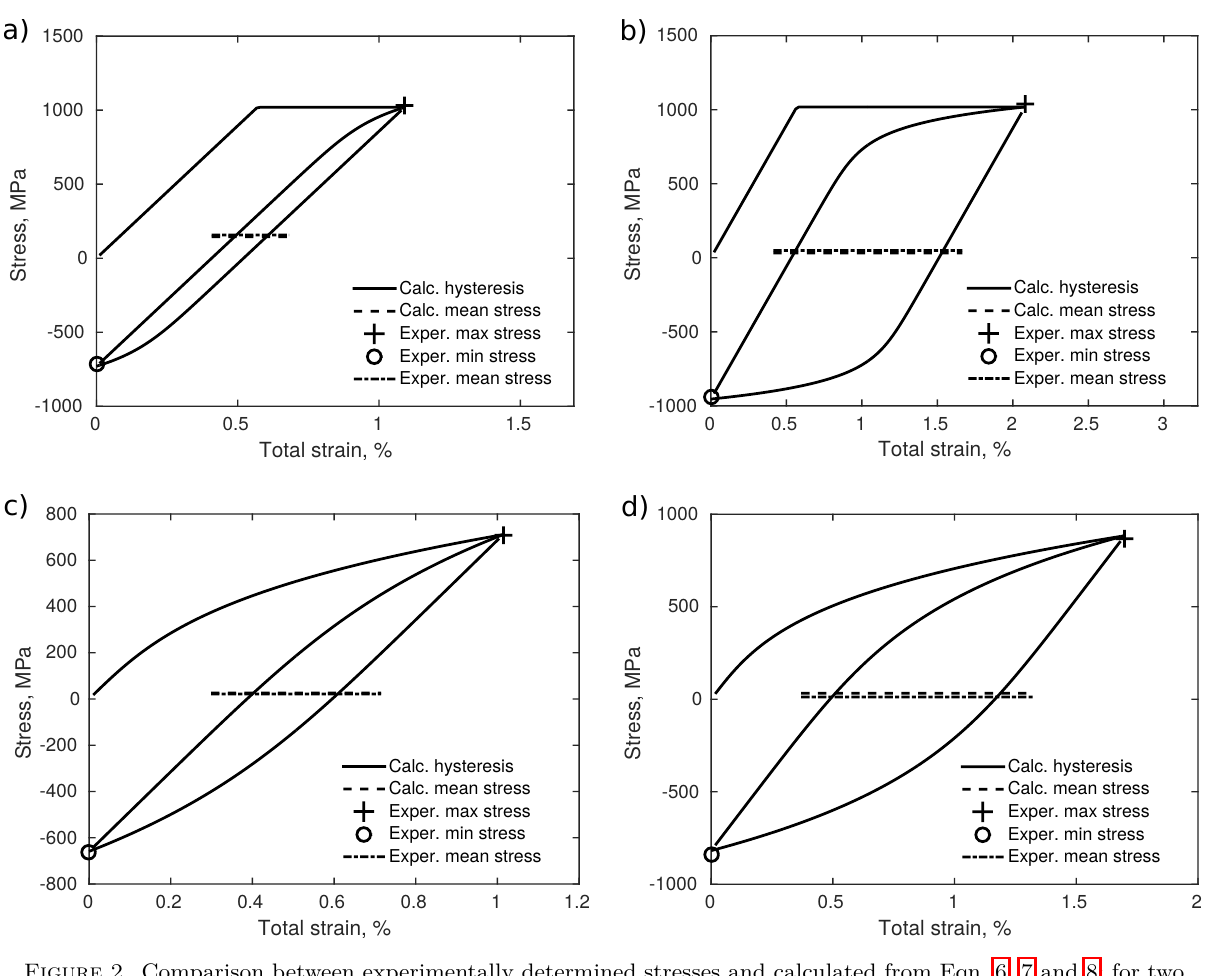
Table 1. Material parameters fitted to data from Ref. [7–9].